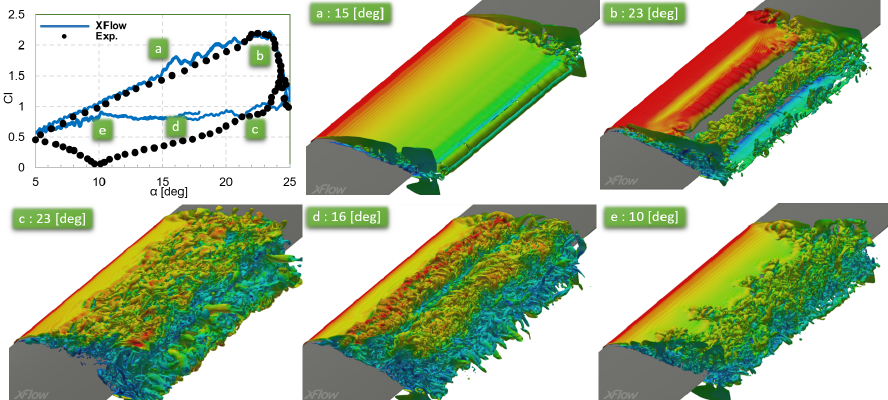
Figure 14. Dynamic stall for a NACA0012 airfoil at different angles of attack (( a ): 15 deg, ( b ): 23 deg, ( c ): 23 deg, ( d ): 16 deg, ( e ): 10 deg): lift curve hysteresis ( top-left ) and 3D vorticity iso-surface at different angles of attack, with Re = 0.98 · 10 6 and k =